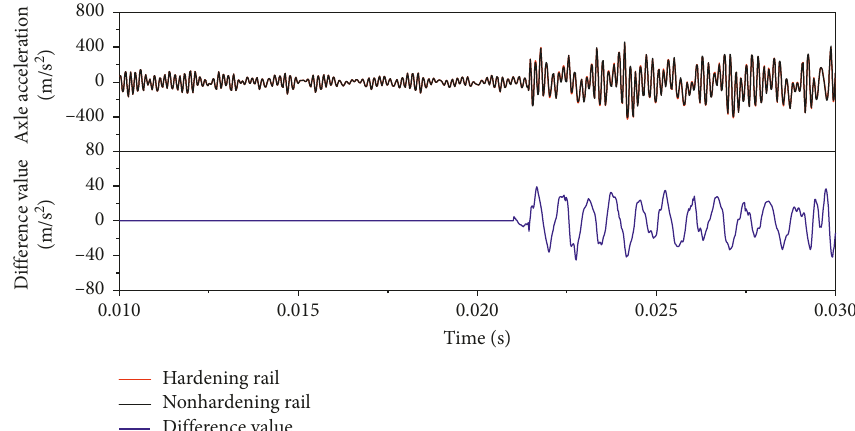
Figure 16: Time history curve axle acceleration and difference value between nonhardening material and hardening material.